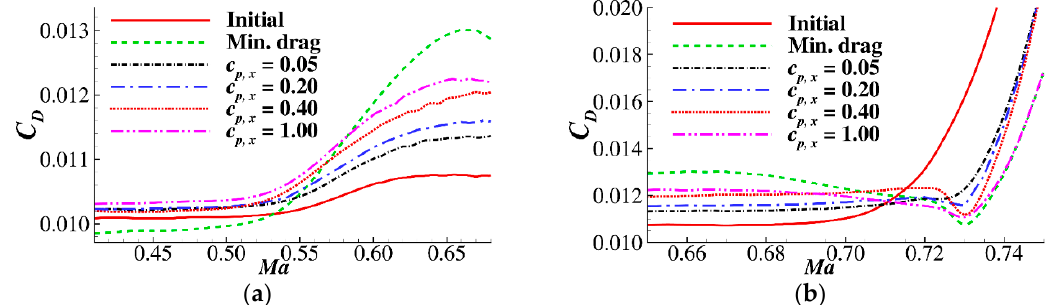
Figure 15. Drag creep and drag divergence of the airfoils ( Re = 6.5 × 10 6 , C L = 0.800). ( a ) Drag creep; ( b ) drag divergence.